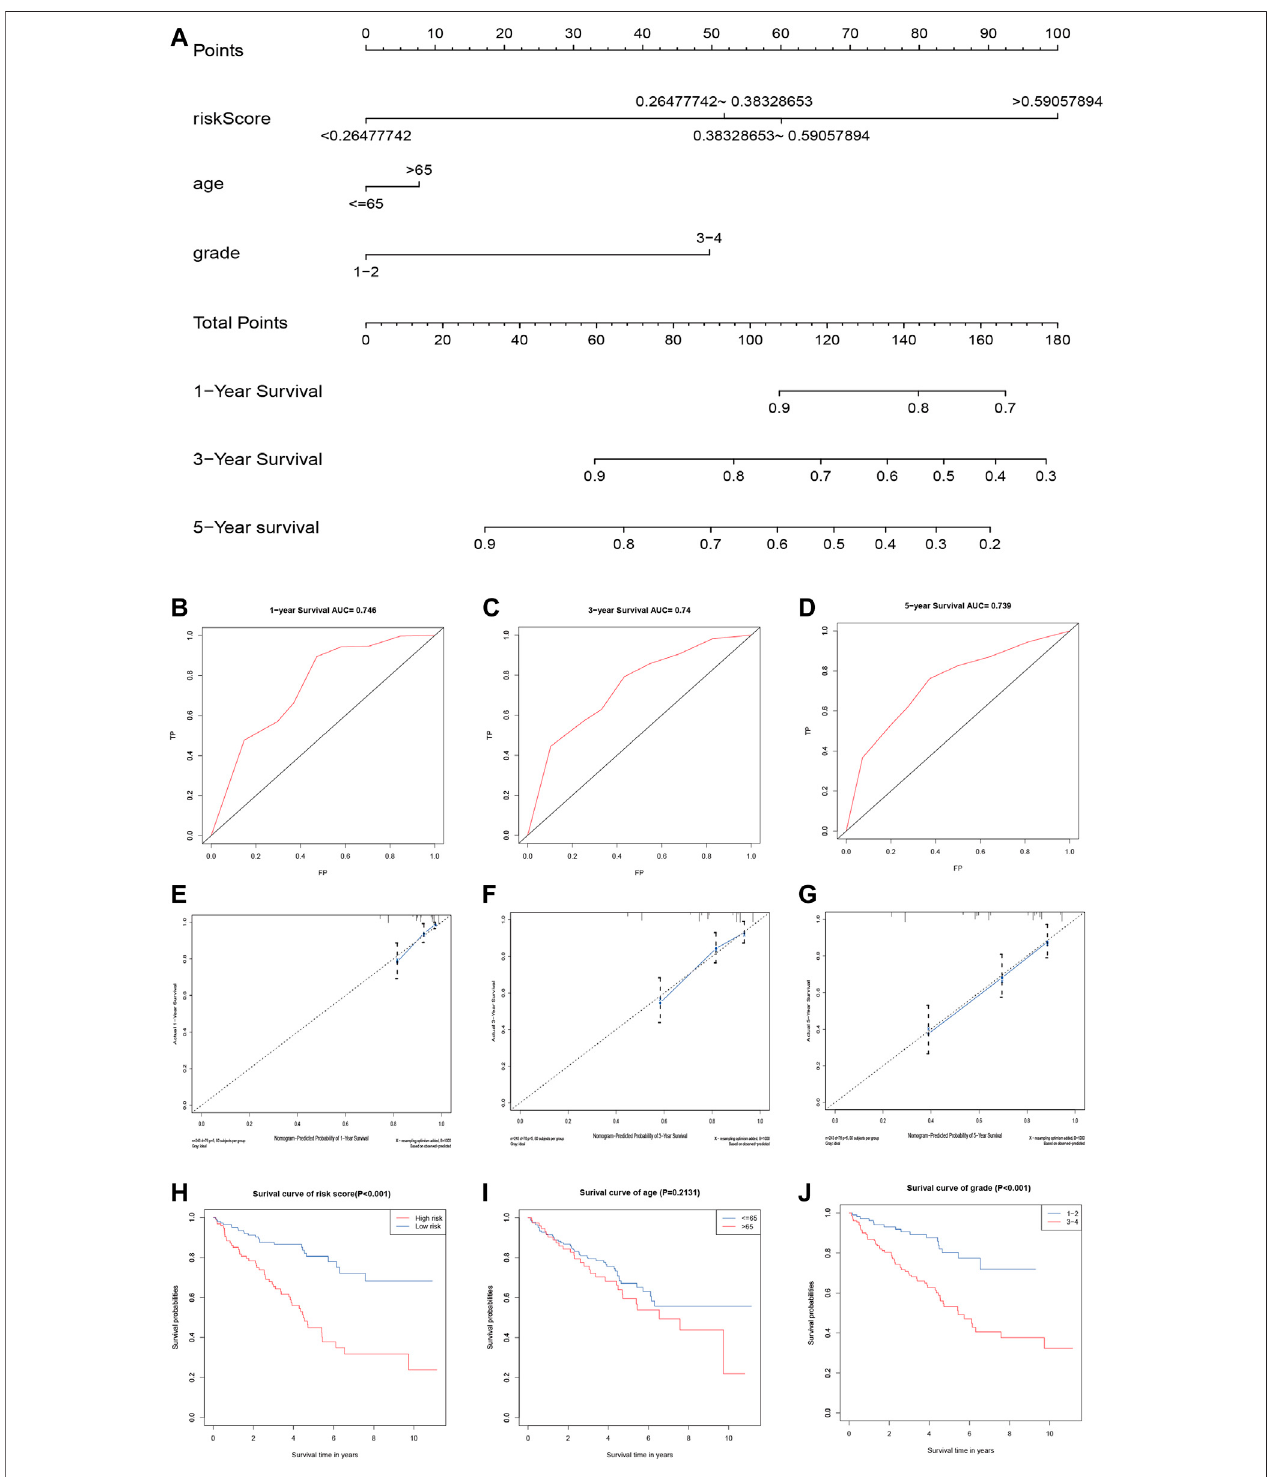
FIGURE 6 | Validation of the prognostic signature of the fi ve related regulators. (A) The nomogram of the risk model for predicting the OS probability of ccRCC patients.Thewholepointsprojectedonthebottomscalesindicatethelikelihoodof1-,3-,and5-yearOS. (B – D) AUCoftheROCanalysisshowedthepredictedef fi cacy oftheriskmodelinthetrainingset. (E – G) Thecalibrationplotforthenomogrampredicting1-,3-,and5-yearOS.The y -axisindicatestheactualsurvival,asmeasuredby the K – M analysis, while the x -axis shows the nomogram-predicted survival. (H – J) Kaplan – Meier survival curves strati fi ed according to clinicopathological and risk